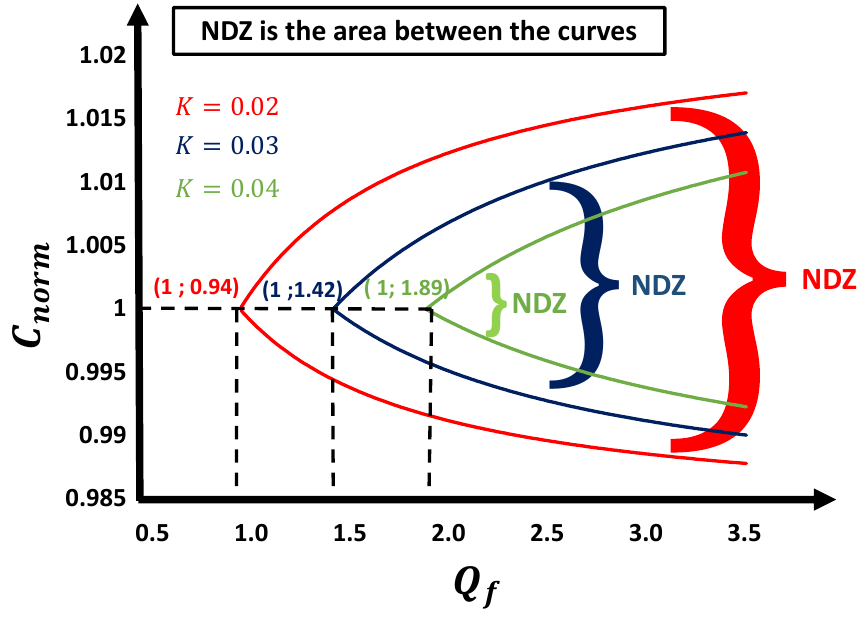
Figure 3. SFS NDZ for different values of 𝐾 .